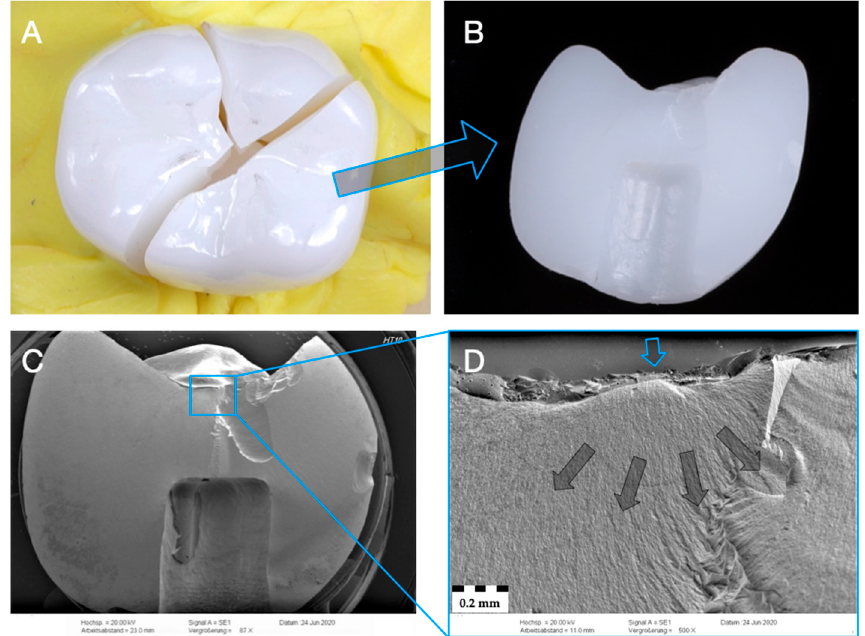
Figure 5. Representative specimen of Group Z-HT after single-load-to-fracture assessment. Light microscopy shows ( A ) occlusal view of bulk fractured specimen and ( B ) side view of fractured part marked with blue arrow. SEM pictures: ( C ) overview of fractured part at low magnification of ( B ). Detailed view at high magnification ( D ): blue arrow indicates fracture initiation point, while dark arrows represent the direction of crack propagation.